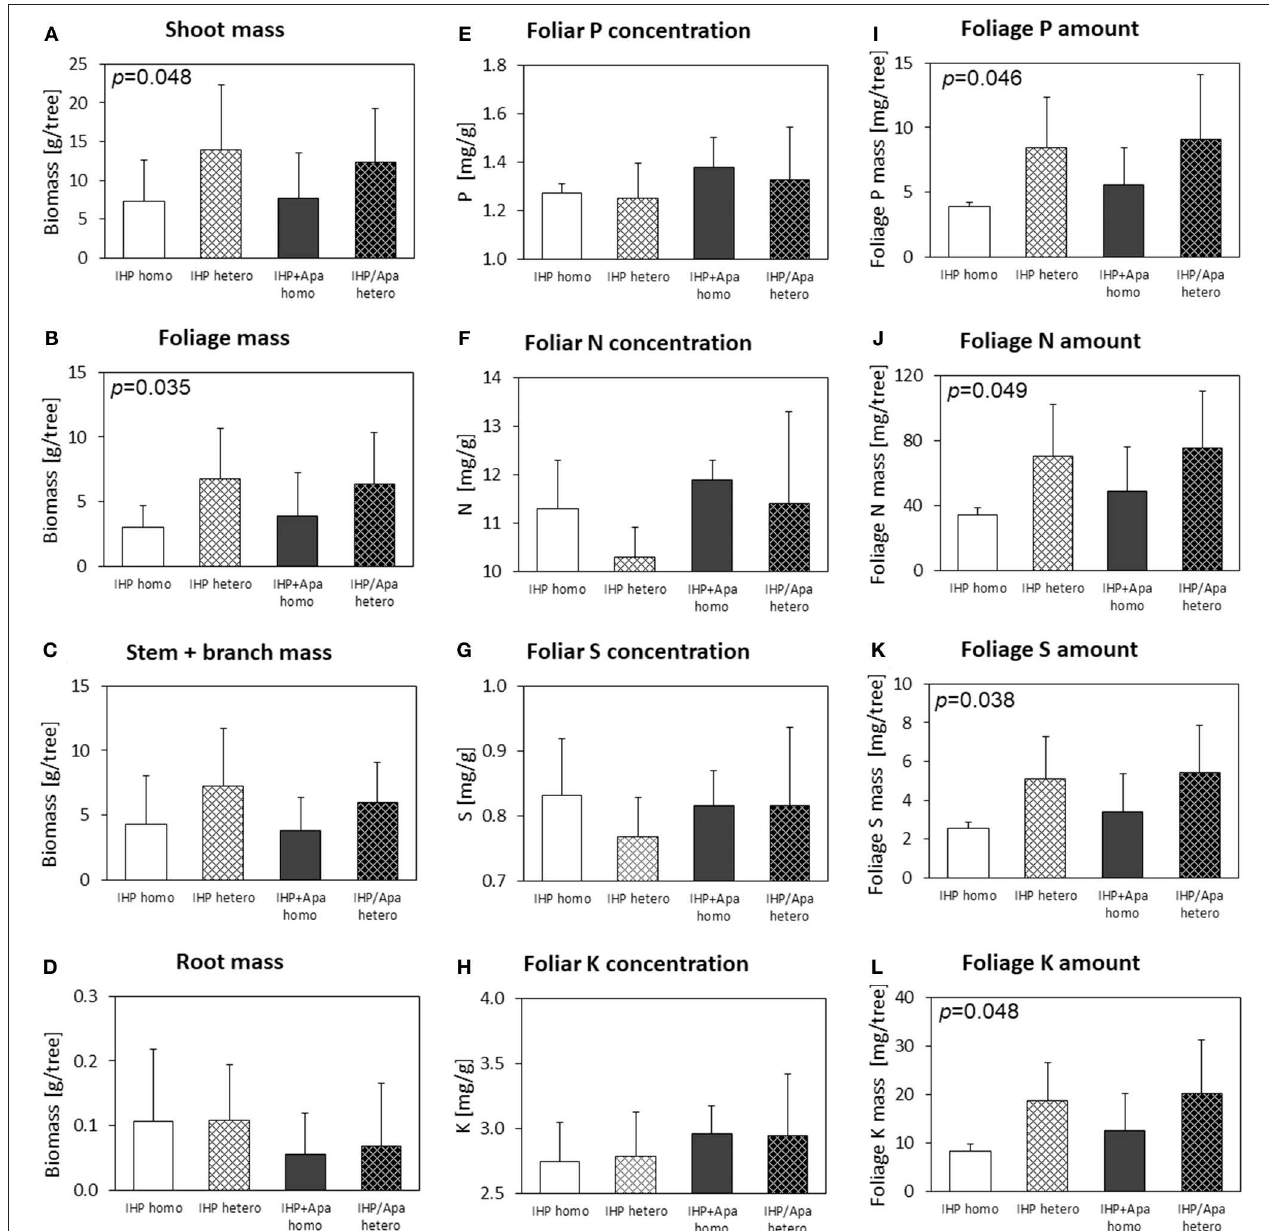
FIGURE 4 | Shoot (A) , foliage (B) , stem + branch (C) , and root (D) biomass, foliar concentrations of N (E) , P (F) , S (G) , and K (H) , and nutrient (P, N, S, K) amounts in foliage (I–L) of Picea abies at the low-P calcareous site. Numbers in the upper left panel corner show p < 0.1 for differences between mean values of homogeneous vs. heterogeneous P application calculated by one-way ANOVA.